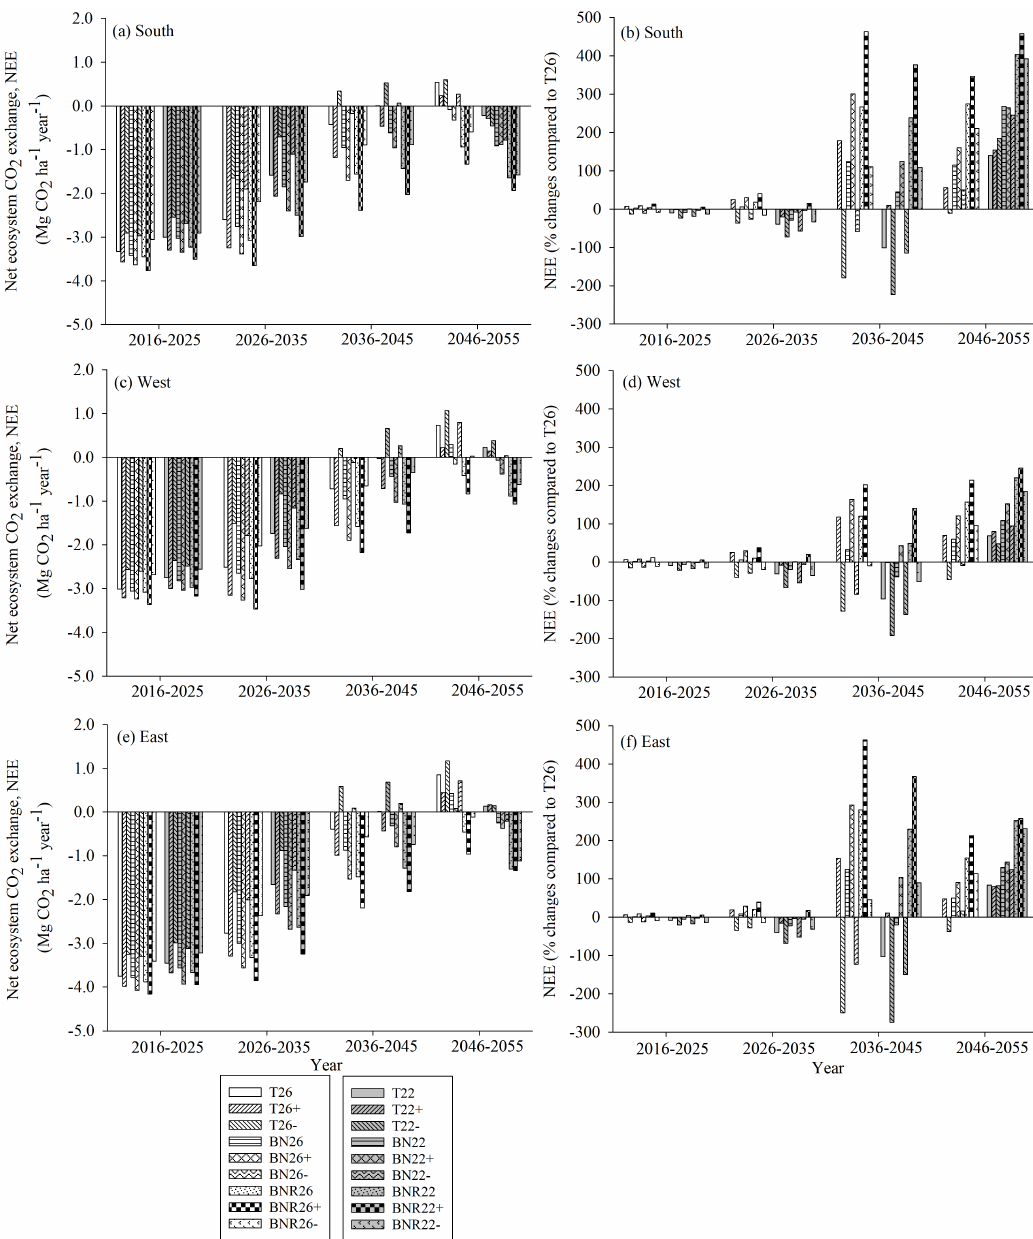
Figure 4. Mean annual net ecosystem CO 2 exchange, NEE (Mg CO 2 ha − 1 year − 1 ) ( left ) and relative difference (% changes) in NEE ( right ) for four 10-year period for different management scenarios, compared to baseline management (T26) and under three different harvest intensities including timber (T), timber and logging residues, without (BN) and with coarse roots and stumps (BNR) in the final felling made at DBH of 26 cm and 22 cm in southern ( a , b ), western ( c , d ) and eastern ( e , f ) sub-regions of Finland. For the key of the management scenarios, see Table